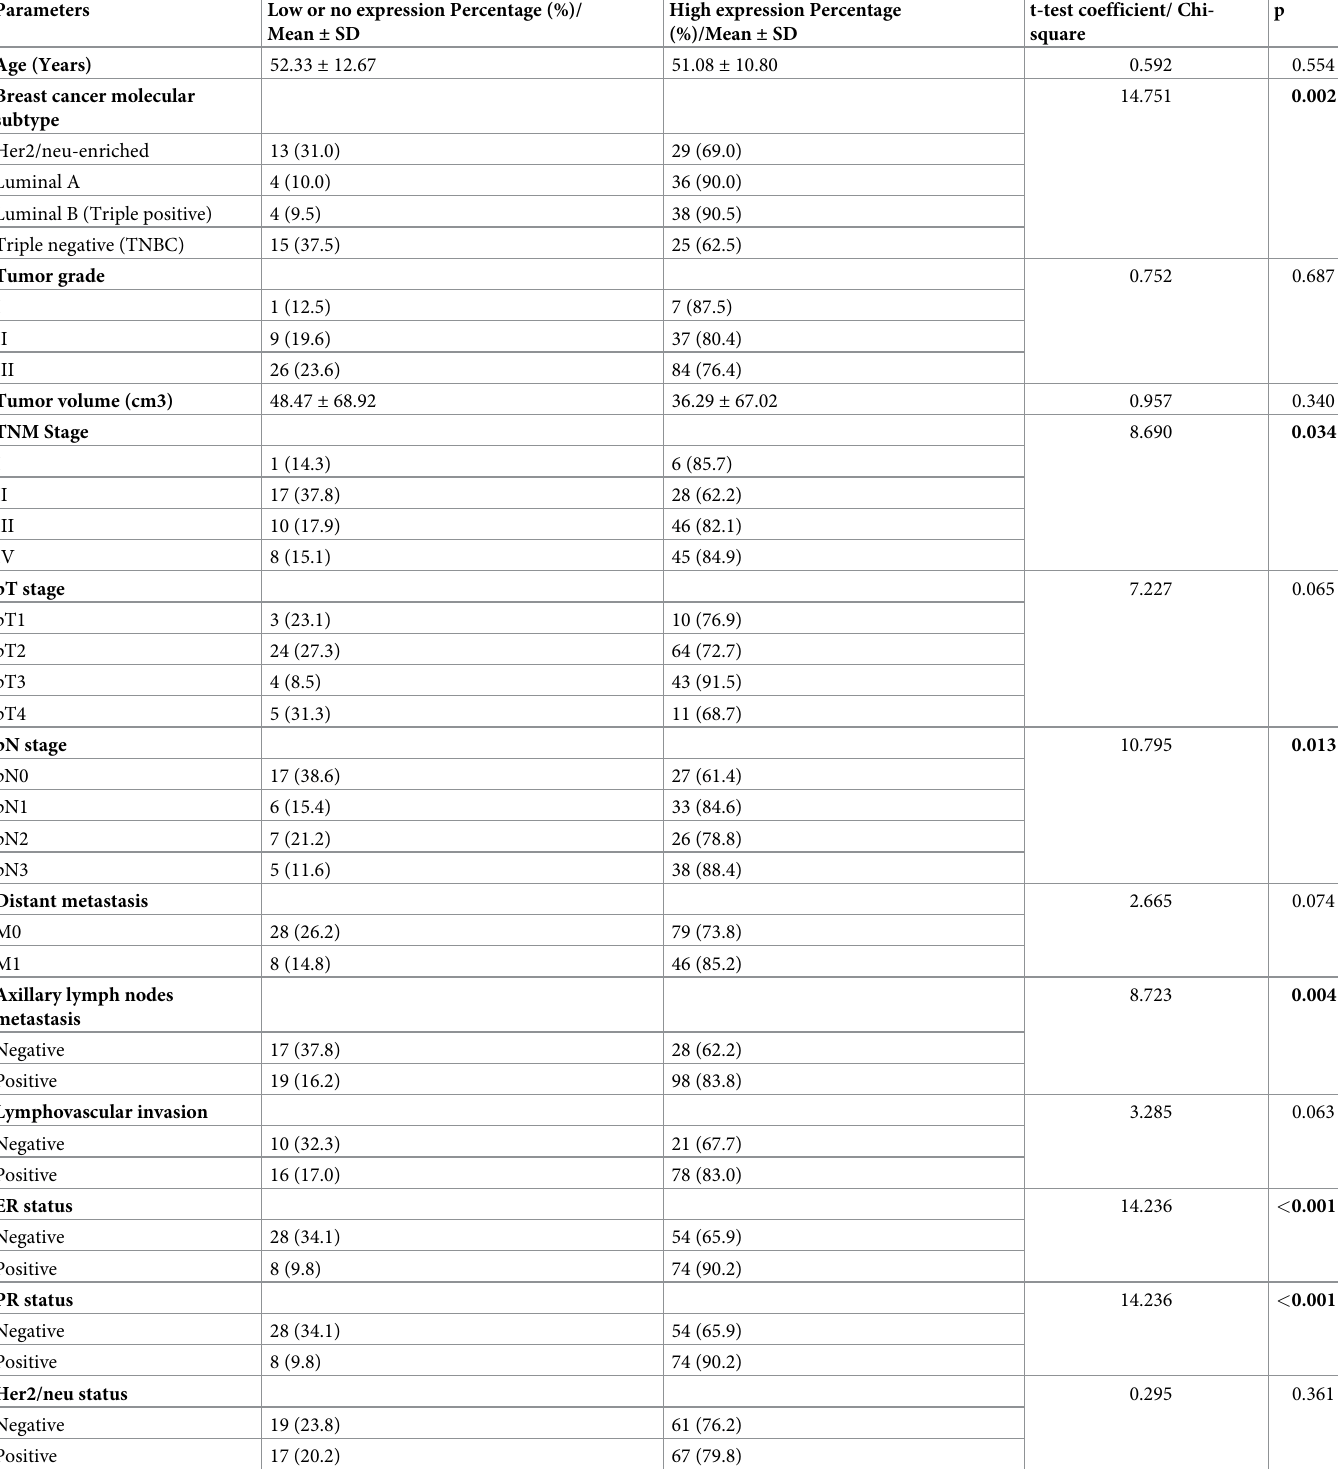
Table 2. Clinicopathological features of breast cancer patients in relation to Substance P (SP)